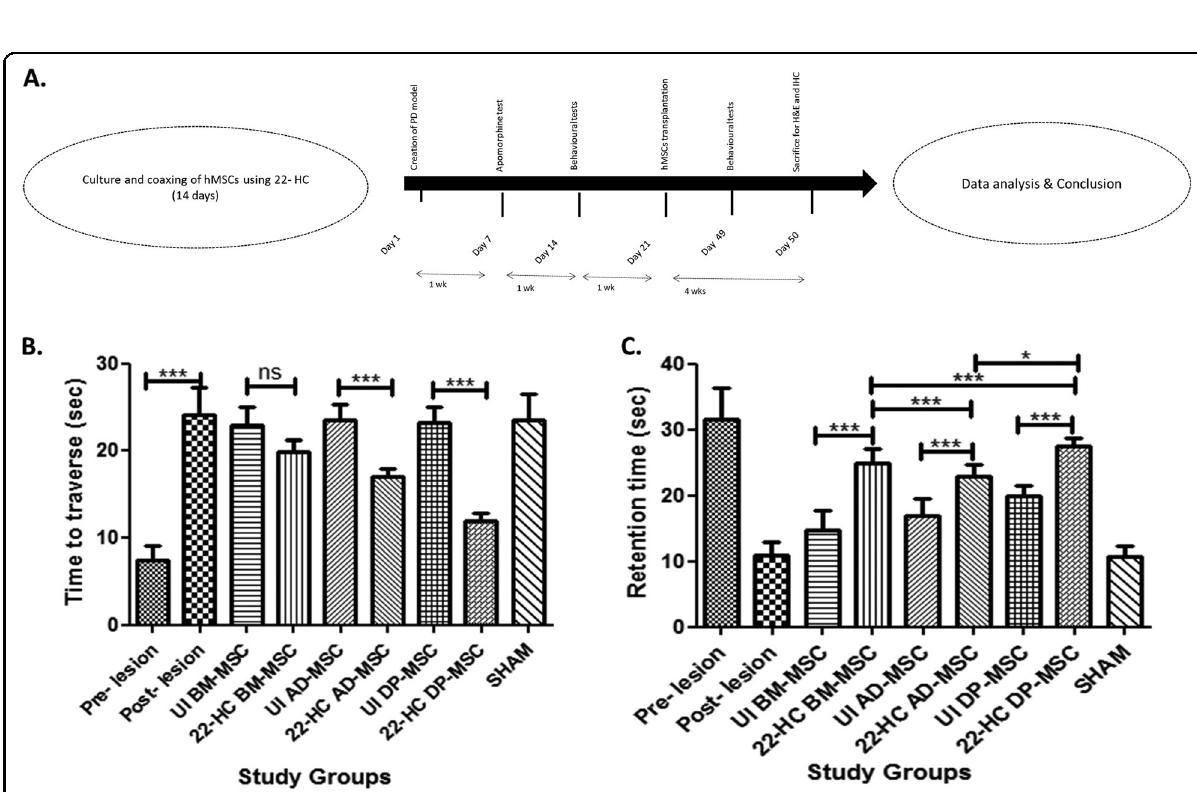
Fig. 7 Validation of in vitro results in Wistar rat PD models. A Schematic representation to show the sequence of in vivo stem cell transplantation experiments. B Balance beam test: restoration of motor de fi cit function in rats who received either naïve or differentiated hMSCs. While the motor function in all the rats was reduced signi fi cantly after creation of lesion by 6-OHDA, it was reduced further signi fi cantly upon hMSCs transplantation, with maximum effect in case of differentiated DP-MSCs. This test was performed 4 weeks after transplantation of hMSCs. Data points represent the means ±SD ( n = 5), * p <0.001 vs. control untreated cells. C Rotarod test: The retention time of the rats was increased signi fi cantly after transplanting them with hMSCs in naïve or differentiated form. However, the restoration of motor neuron function was the most in case where differentiated DP-MSCs were